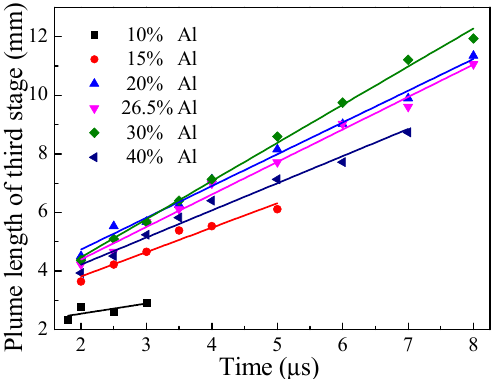
Figure 13. The plume length of third stage variation with time and its linear fitting at different proportions of Al (ambient pressure 0.005 Pa and laser energy 542.3 mJ).